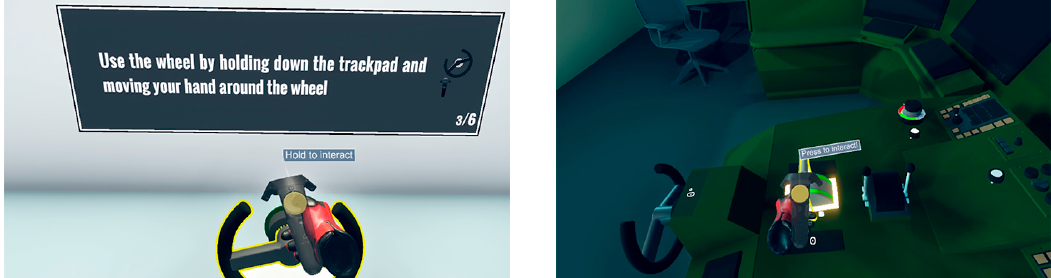
Figure 3. Tutorial and replicated command bridge environment.